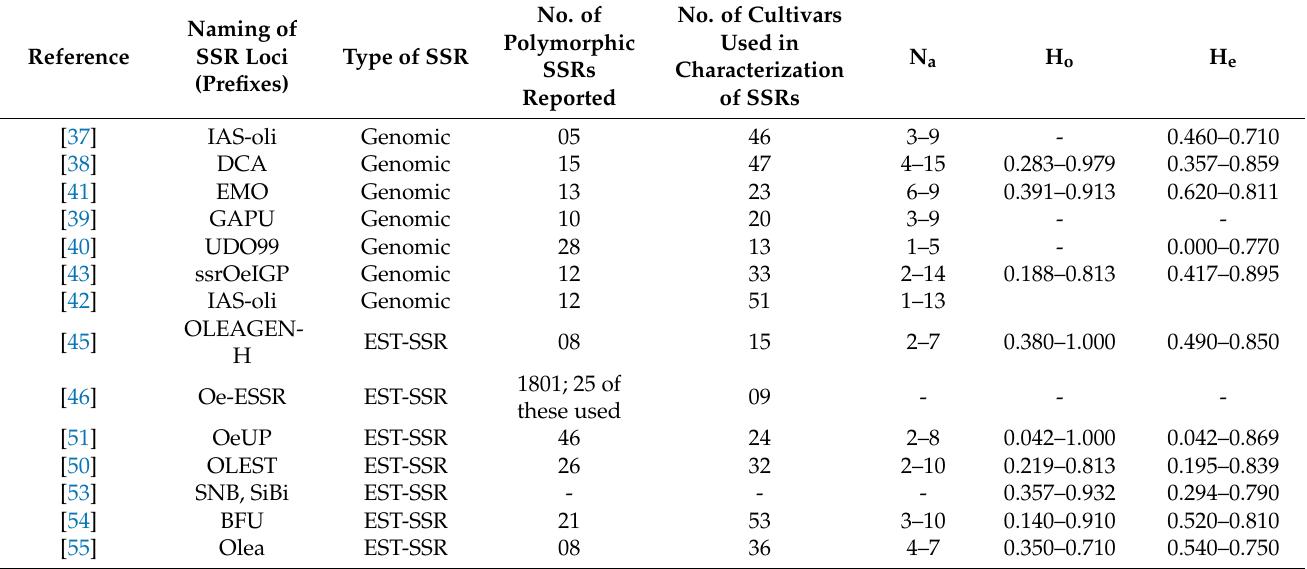
Table 1. Key genetic indices as reported for SSR markers developed in olives using enriched genomic libraries and EST